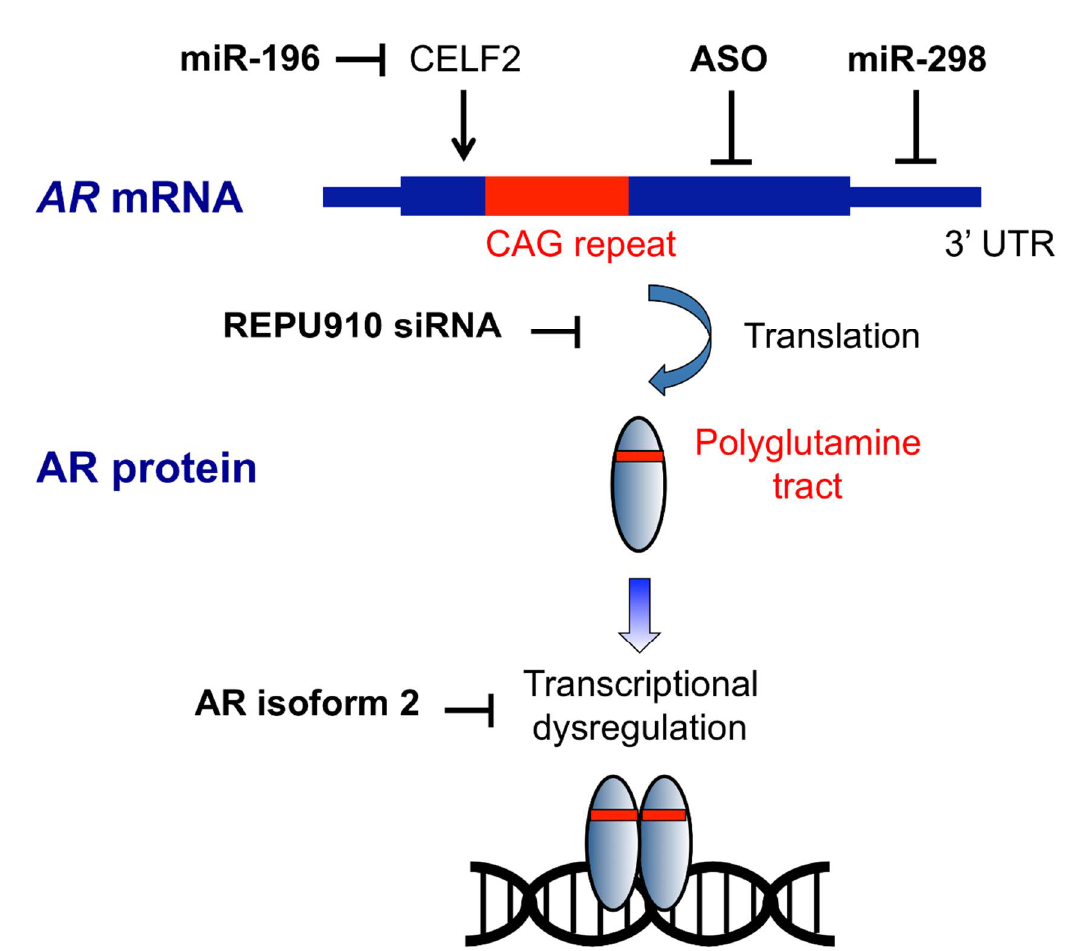
Figure 1. Targets of nucleic acid-based therapeutic strategy in SBMA. ASOs bind to AR mRNA and trigger RNase H cleavage and RNA degradation. REPU910 targets expanded CAG repeats, proba- bly through decreasing mRNA stability and translation. Mir-196 silences the CELF2 gene, which upregulates AR expression by enhancing the stability of AR mRNA. MiR-298 directly binds to the 3′-untranslated region (UTR) of AR mRNA and downregulated the mRNA levels. AR isoform 2 restores transcriptional dysregulation caused by polyglutamine-expanded AR. Table 2. Studies of nucleic acid-based therapeutic approaches in SBMA.